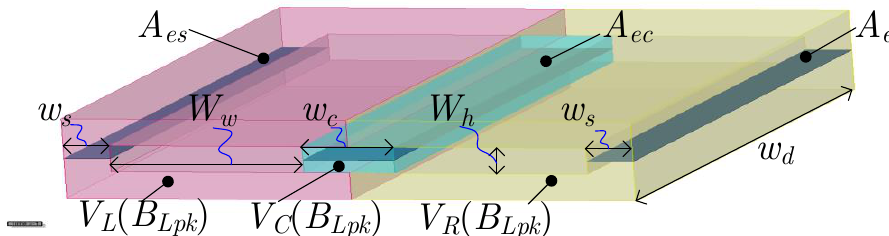
Figure 7. 3D model of a magnetic core.